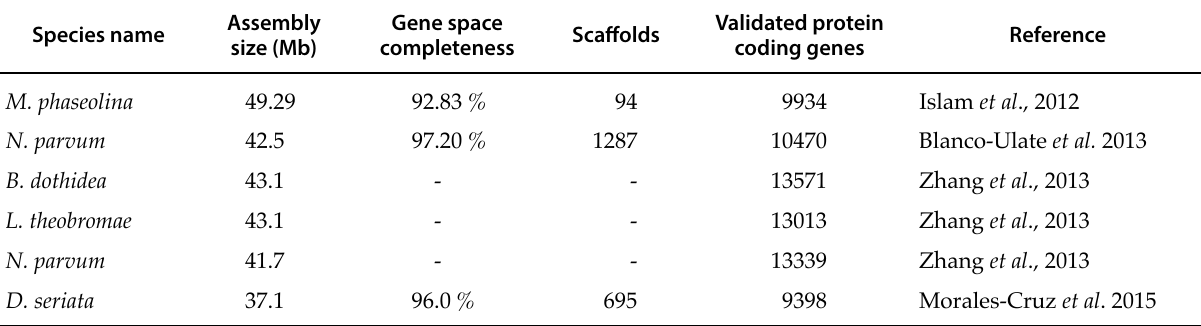
Table 3. Features of assembled genomes in Botryosphariaceae